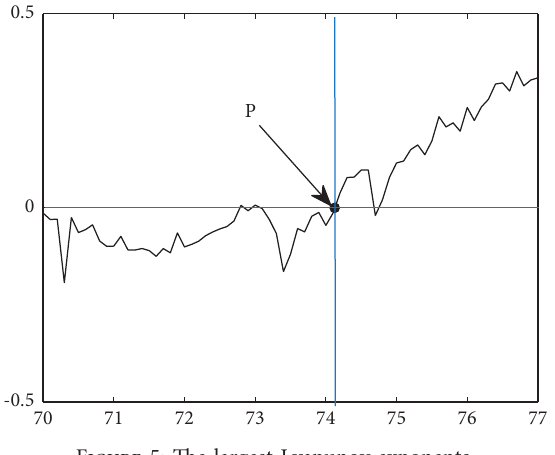
Figure 5: The largest Lyapunov exponents.